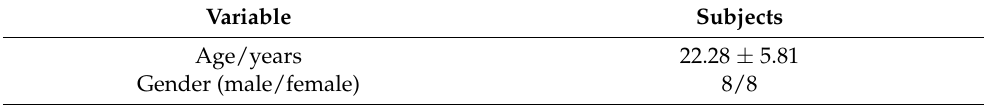
Table 1. Basic information on